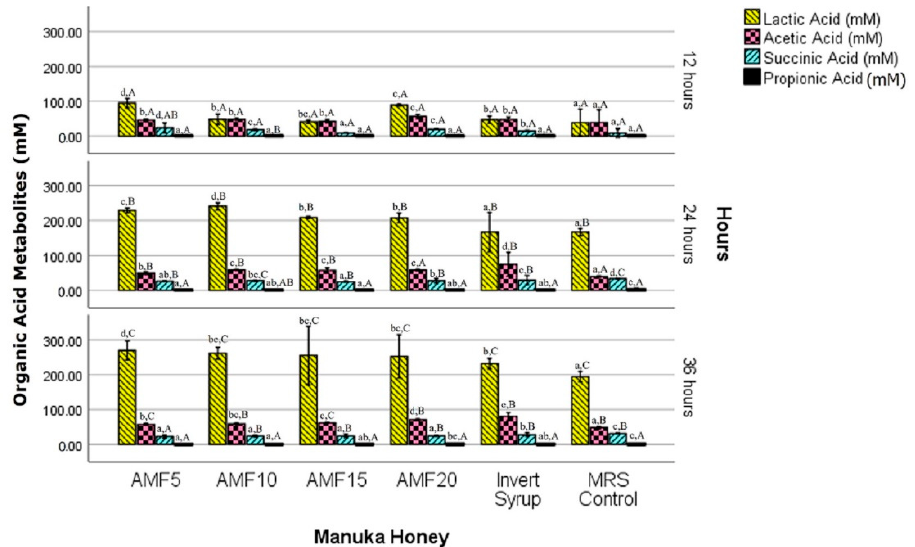
Figure 4. Concentration (mM) of organic acid metabolites in MRS broth with Manuka honey (AMF TM 5 + , 10 + , 15 + and 20 + ), invert syrup and unsweetened control during the fermentation period (12, 24 and 36 h). Error bars represent 95% confidence intervals (CI). Different lowercase letters denote significant differences ( p < 0.05) among the samples in a row (for that particular organic acid). Different uppercase letters denote significant differences ( p < 0.05) among the fermentation periods in a column (for that particular sample).